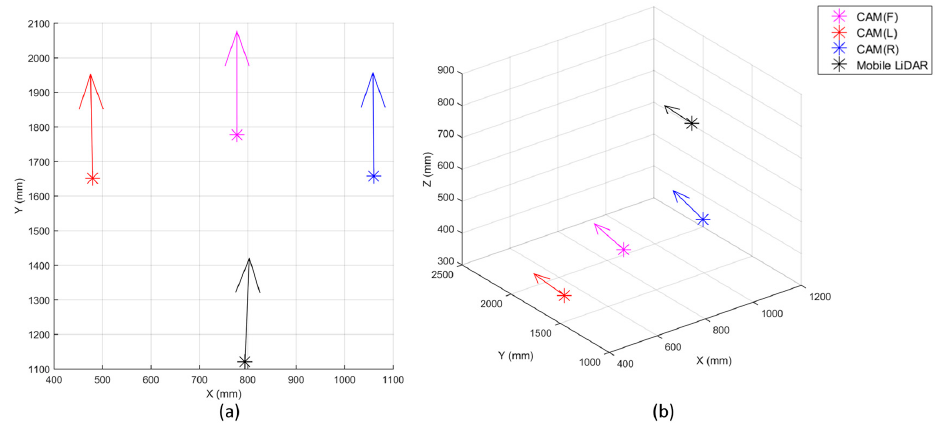
Figure 13. Boresight and lever-arm calibration results (In case of CAM(F), CAM(L), and CAM(R), the direction vectors in sensor frame are [0 0 1]. In case of mobile laser scanner, the direction vector in sensor frame is [1 0 0]): ( a ) 2-dimensional view; ( b ) 3D view.